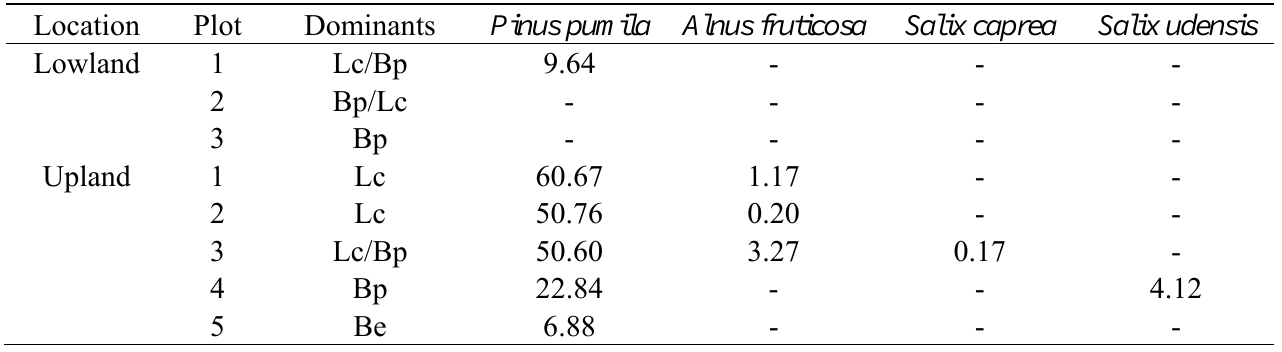
Table 8. Percentage subcanopy cover within old-growth forest plots in Central Kamchatka. Table 2); Lc = Larix cajanderi , Bp = Betula platyphylla , Be = B. ermanii